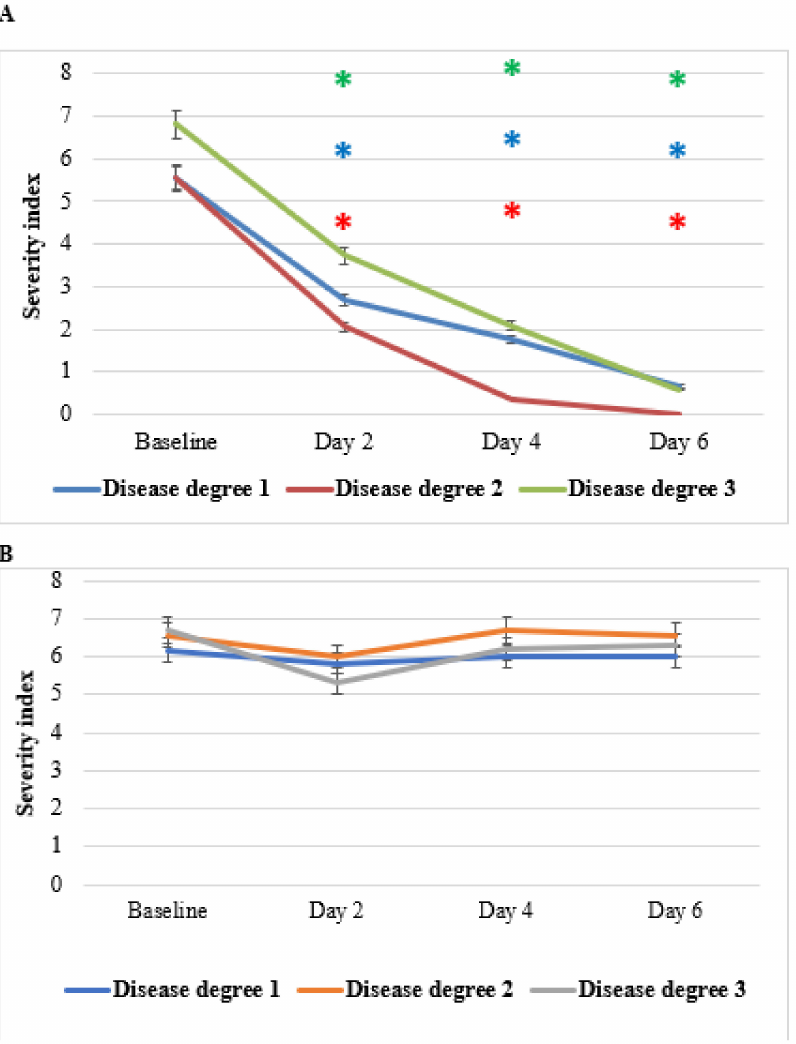
Figure 10. Effect of anti-hemorrhoidal polyherbal cream (HPC) on pain severity. Disease degree 1 (HPC, n = 9; placebo, n = 7), 2 (HPC, n = 19; placebo, n = 7), and 3 (HPC, n = 26; placebo, n = 10). * p < 0.01—significant as compared with